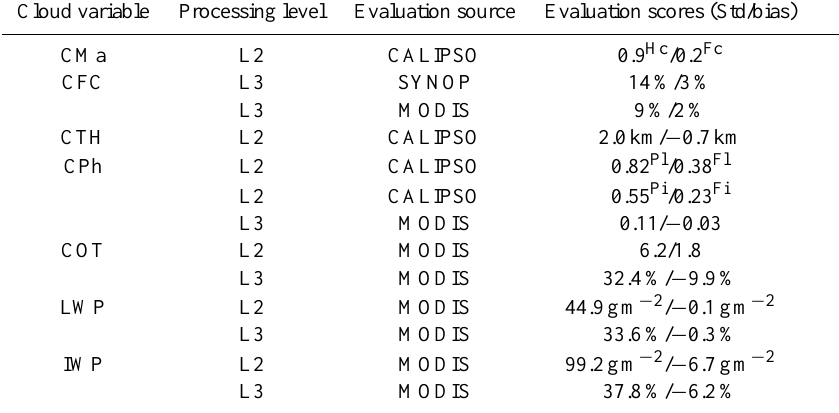
Table 4. Summary of evaluation scores for CLAAS products as there are given in Kniffka et al. (2013a). Processing level L2 stands for pixel-based products, while L3 refers to monthly averages. The values of standard deviations and biases are reported. Subscripts Hc and Fc refer to hit rate and false alarm for cloud detection. Similarly, Pl, Pi are the probabilities of detection for liquid and ice clouds, while Fl, Fi are corresponding false alarm rates. L2 comparison results for COT, LWP and IWP against MODIS were, in contrast to Kniffka et al. (2013a), extended to cover one month of collocations.